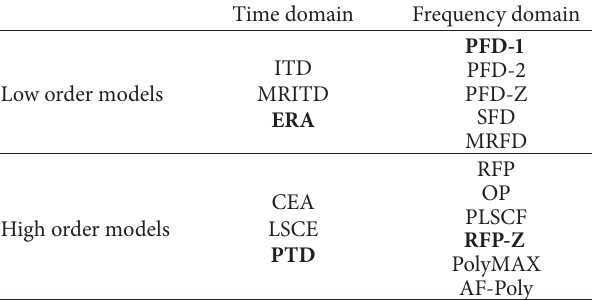
Table 2: Four corners of modal parameter